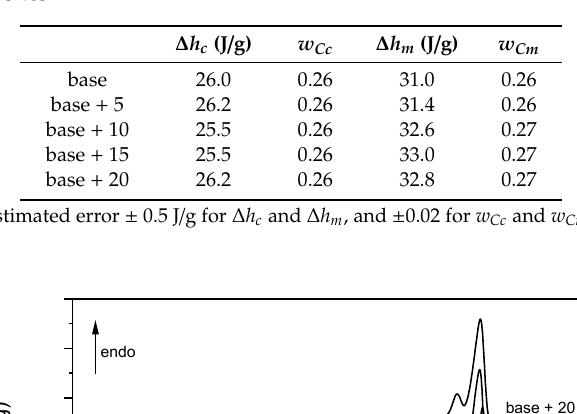
Table 2. Enthalpy of cold crystallization ( ∆ h c ) and enthalpy of fusion ( ∆ h m ), crystalline weight fraction growing during cold crystallization ( w Cc ) and disappearing during fusion ( w Cm ) for the PLA / PBAT matrix and biocomposites.